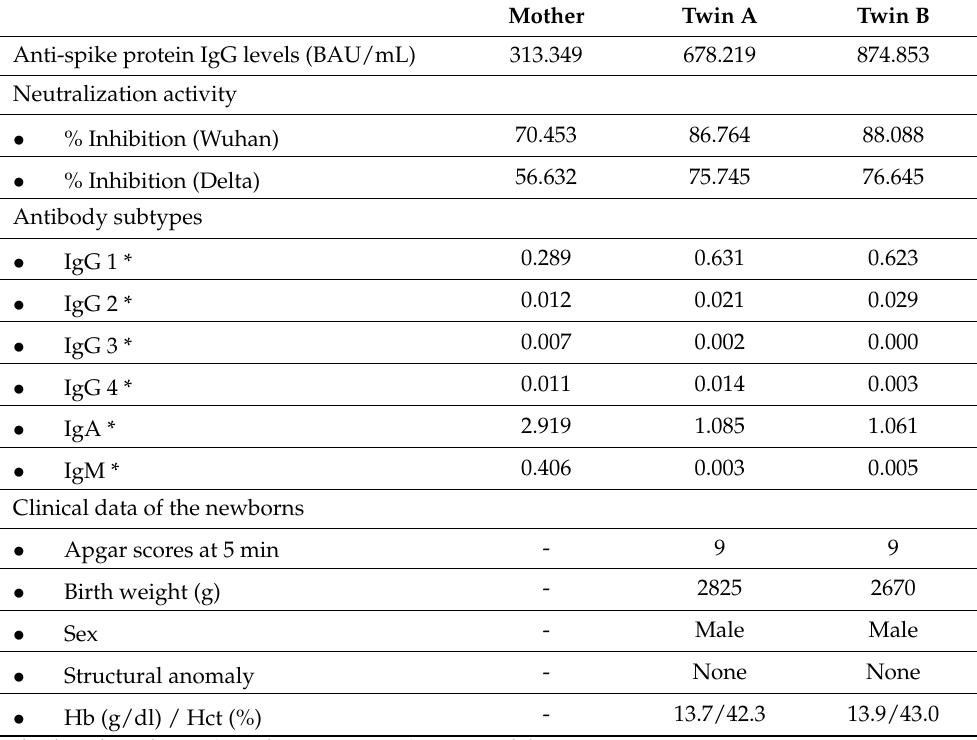
Table 1. Comparisons of immunization profiles between the mother and both